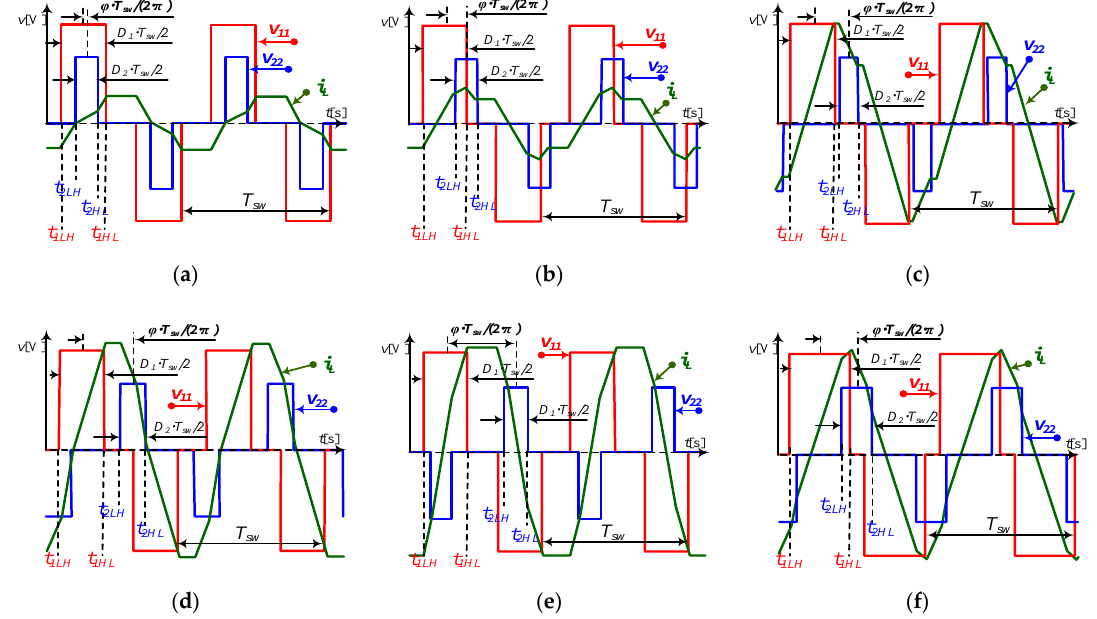
Figure 4. Case I: Switching modes for φ > 0. ( a ) SM 1 ; ( b ) SM 2 , SM 2 *; ( c ) SM 3 ; ( d ) SM 4 ; ( e ) SM 5 , and ( f ) SM 3 *.